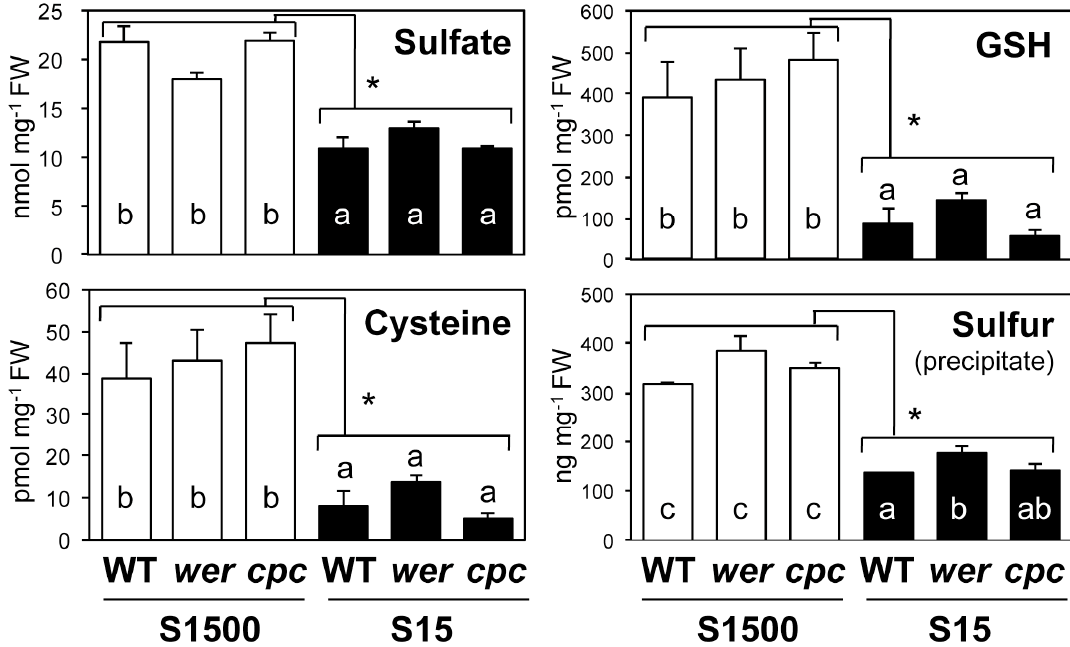
Figure 5. Accumulation of sulfate, cysteine (Cys), glutathione (GSH), and sulfur in shoots of wild-type (WT), werwolf ( wer ), and caprice ( cpc ) mutants grown under S1500 and S15 conditions. Plants were vertically grown for 10 d on S1500 (white bars) and S15 (black bars) agar media. Sulfate content in shoot tissues was determined using ion chromatography. Cys and GSH content of shoot tissues was analyzed using a high-performance liquid chromatography (HPLC)-fluorescent detection system, after labeling thiol bases with monobromobimane. Total sulfur content in precipitates was analyzed using inductively coupled plasma-mass spectroscopy (ICP-MS) after nitric acid digestion. Values and error bars indicate means ± SEM (n = 3). Two-way analysis of variance (ANOVA) was used to detect effects of sulfur conditions, genotypes, and their interactions. Asterisks indicate significant differences between S1500 and S15 conditions (two-way ANOVA; * P < 0.05) . As all comparisons did not detect interactions, the Tukey–Kramer test was applied to detect significant differences among genotypes grown under similar conditions. Different letters indicate significant differences ( P < 0.05).